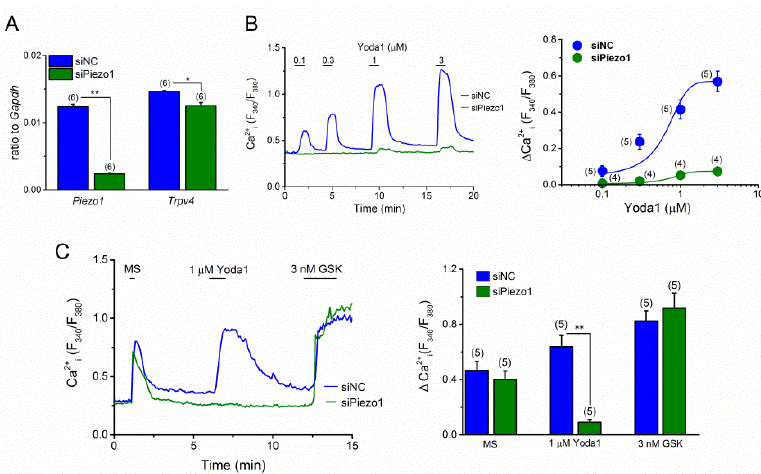
Figure 4. PIEZO1-knockdown in MC3T3-E1 cells and its effect on Yoda1- and MS-induced Ca 2+ response. The expression of PIEZO1 in MC3T3-E1 cells was reduced by siPiezo1 treatment for 96 h. ( A ) The mRNA expression level of Piezo1 and Trpv4 in MC3T3-E1 cells transfected with siPiezo1 compared to the cells transfected with stealth control siRNA (siNC). ( B ) A representative Ca 2 + response to Yoda1 at a concentration ranging from 0.1 to 3 µ M in MC3T3-E1 cells treated with either siPiezo1 (green) or siNC (blue) (left panel). A concentration-response relationship of the peak Ca 2+ change (ΔCa 2+ ) in the cells, treated with either siPiezo1 or siNC, was summarized (right panel). ( C ) The effect of PIEZO1 knockdown on MS-induced Ca 2+ response. A representative Ca 2+ response to MS (7.67 μL/s), Yoda1 (1 μM), and GSK (3 nM) in MC3T3 -E1 cells, treated with either siPiezo1 or